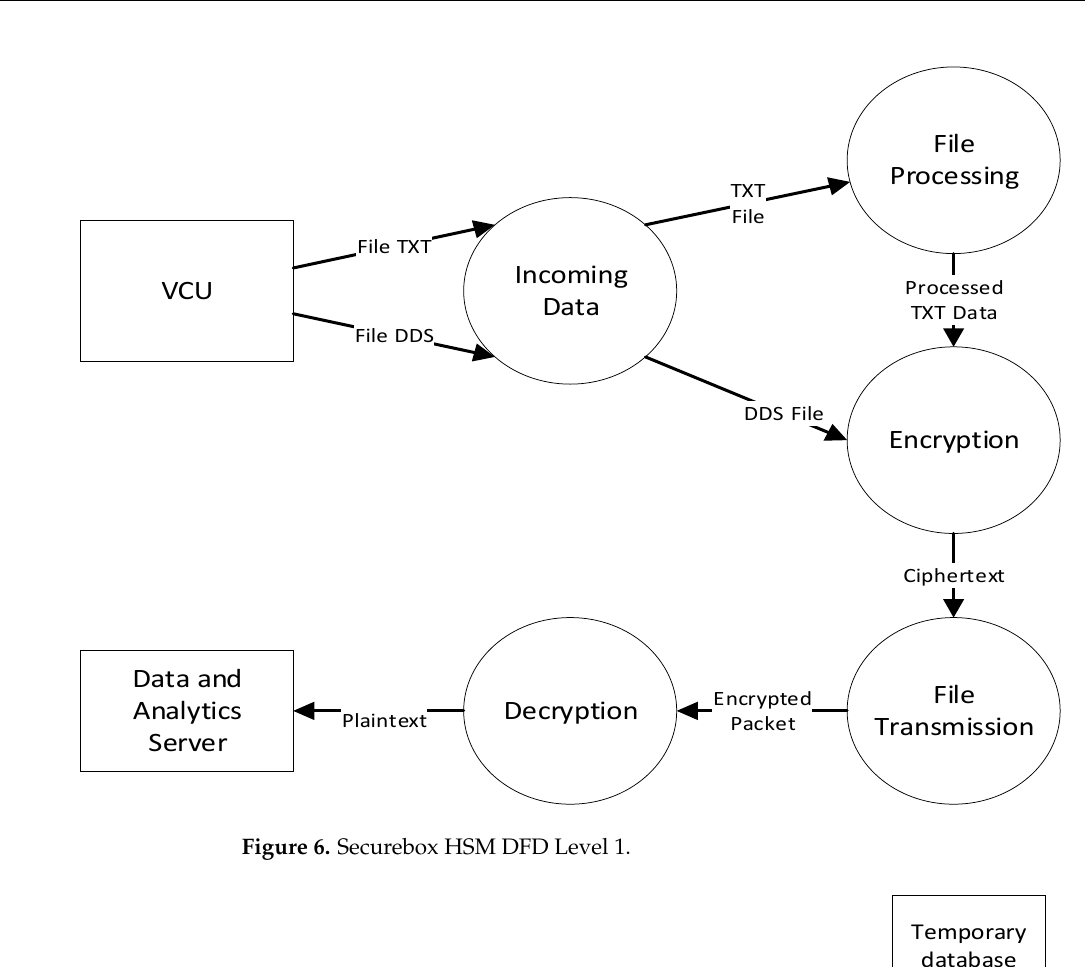
Figure 5. Securebox HSM DFD Level 0.